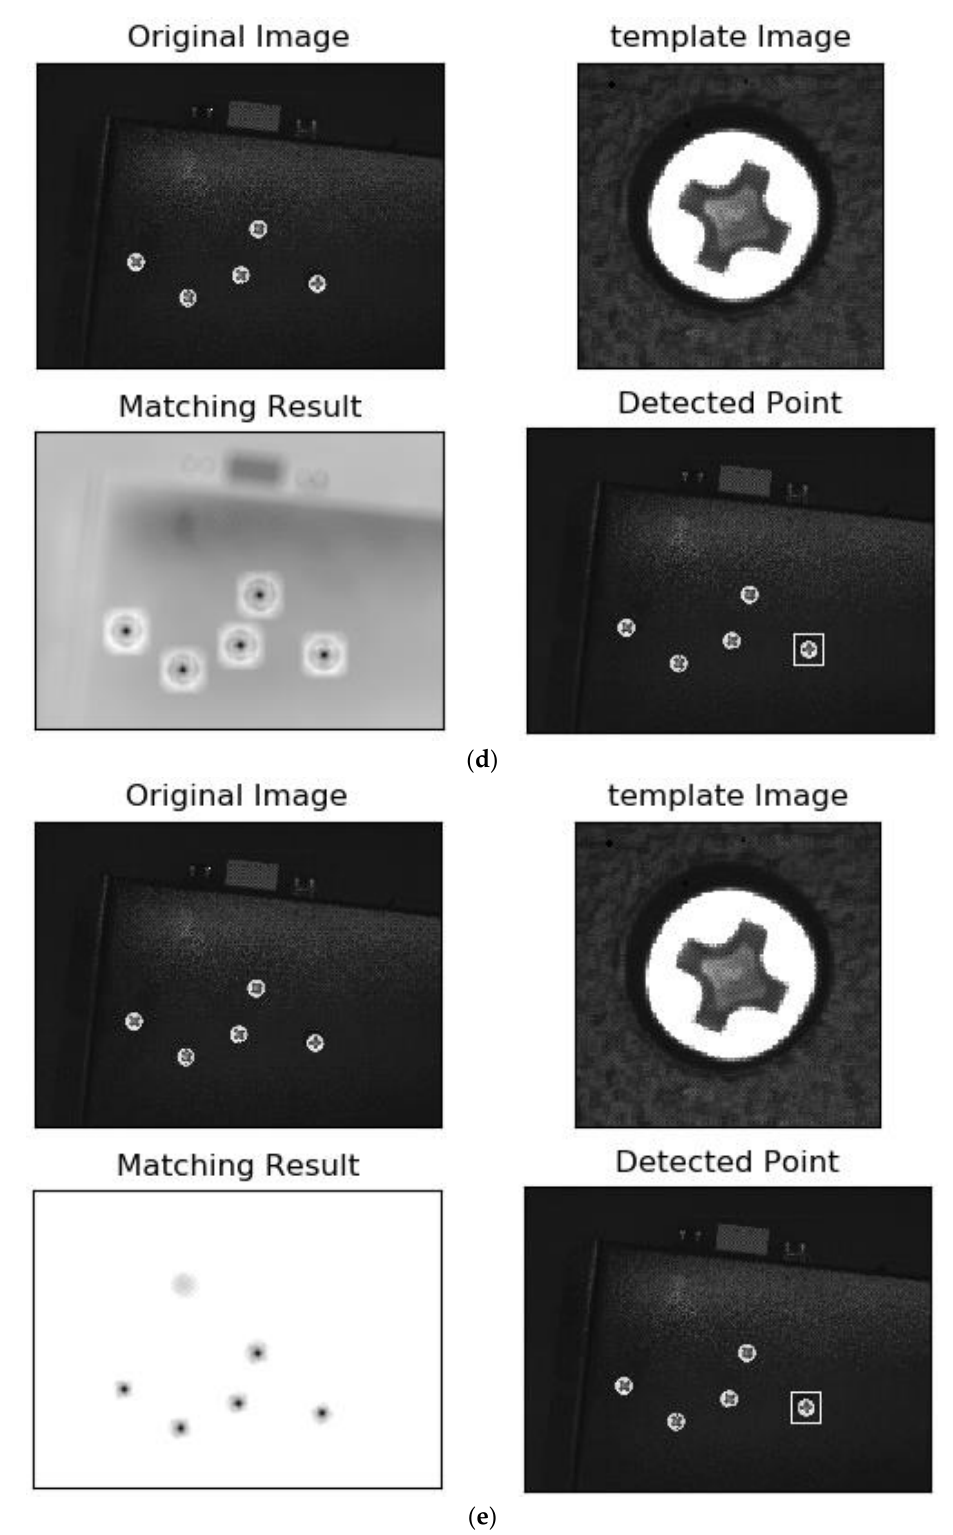
Figure 15. Traditional template matching-based detection methods. ( a ) Normalized correlation matching method; ( b ) Normalized correlation coefficient matching method; ( c ) Correlation coefficient matching method; ( d ) Squared difference matching method; ( e ) Correlation matching method.